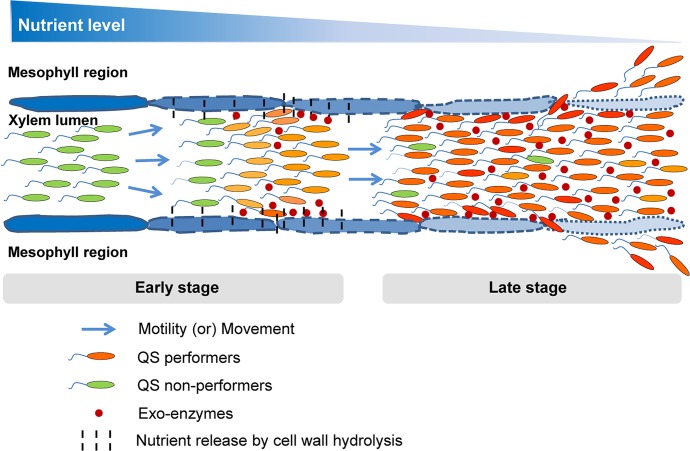
A proposed model for the interplay of heterogeneity and homogeneity in bacterial QS-response in infection.In Xanthomonas campestris pv. campestris QS positively regulate motility, extracellular enzyme (public good) production and promote bacterial dispersal in planta. At the early stage of disease, along with bacterial growth and dispersal within the infected xylem lumens, heterogeneous QS induction happens locally in the sufficiently grown bacterial population, where the QS responders produce exo-enzymes to degrade the surrounding plant cell wall to escape the bacteria into surrounding mesophyll regions and promote systemic spread. In contrast, the QS non-responders utilize nutrients released by the action of exo-enzymes produced by responders. As bacterial density increase at the late stage of disease the QS responders out compete QS non-responder cells as there is nutritional limitation, which may cause growth disadvantage for non-responders which are deficient in spreading to new nutrient rich niche.